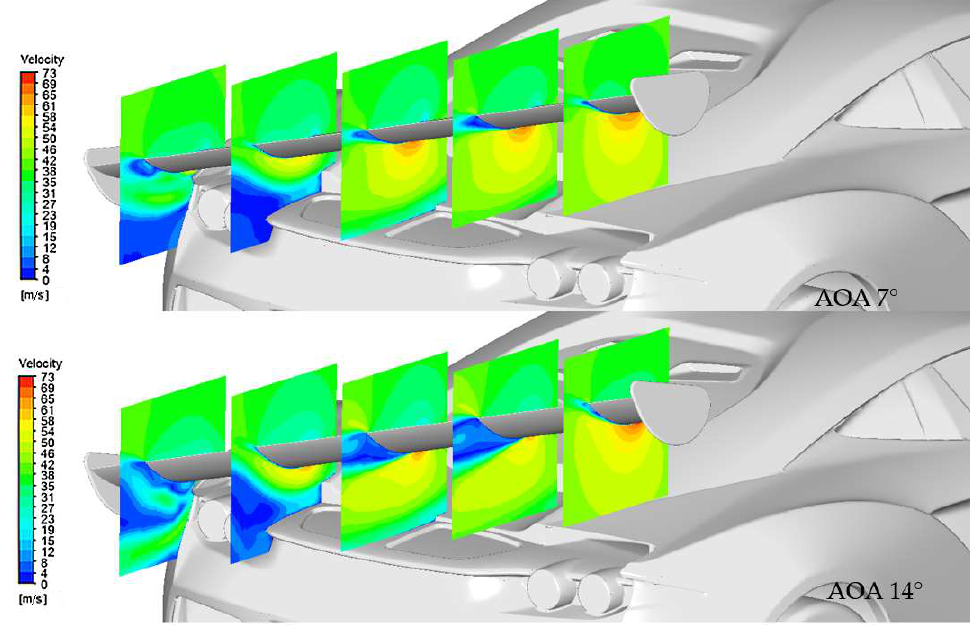
Figure 21. Velocity distributions in several cross sections of the wing.